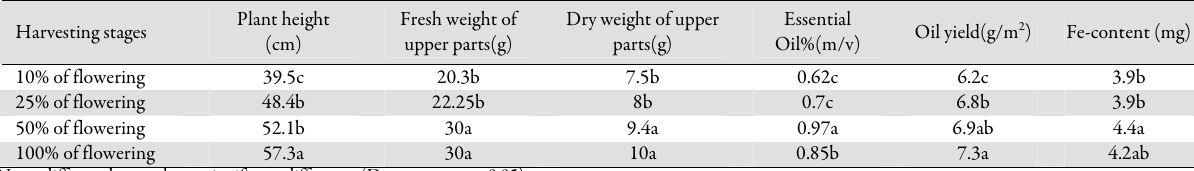
Tab. 2. Effect of harvest time on several characters of Dracocephalum moldavica